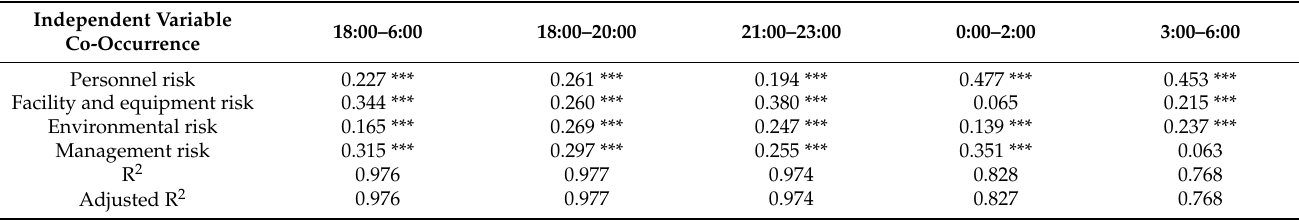
Table 6. Results of the QAP regression